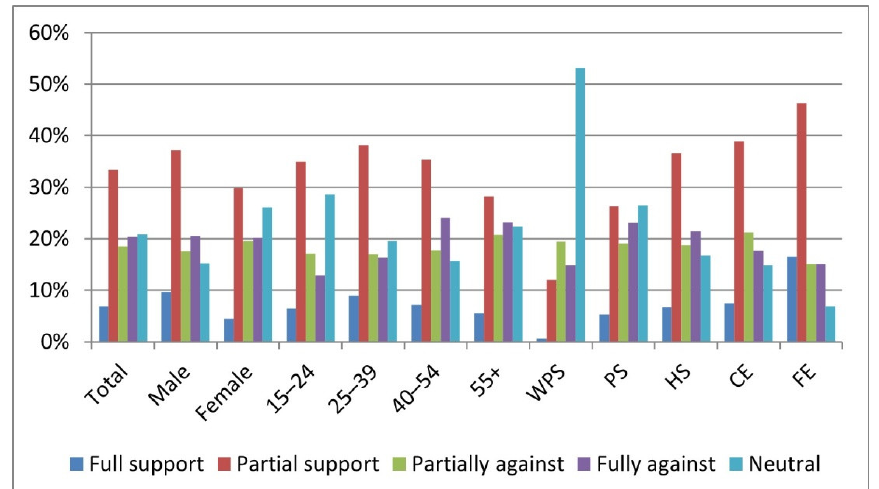
Figure 5. General position toward nuclear energy (WPS–without primary school, PS–primary With smaller deviations, the support for nuclear energy for both genders increases with the level of education, while the percentage of neutral participants decreases. The influence of education on the percentage of opposing participants is not so strongly em- phasized.